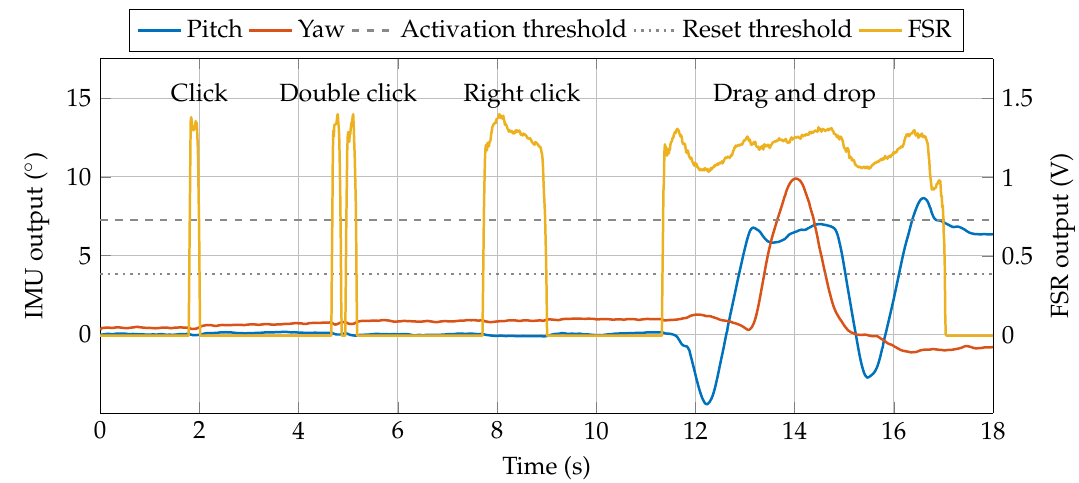
Figure 11. The implemented mouse functionalities. An input is detected when the FSR value exceeds the activation threshold. In order to generate a further input, the value has to fall below the reset threshold first. A short activation generates a left click, whereas maintaining the activation for at least 0.6s results in a right click. A head movement during activation starts the drag and drop function.